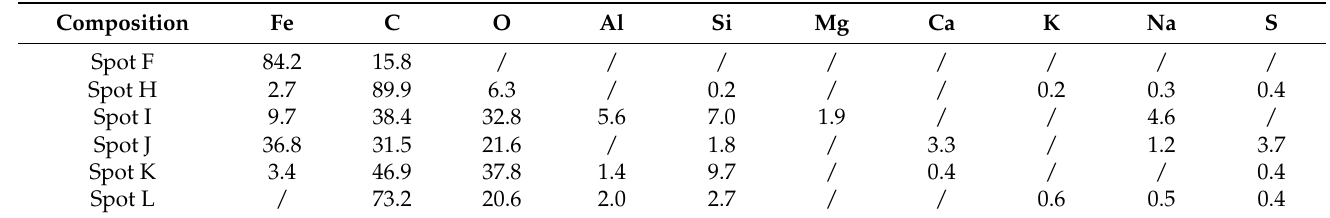
Figure 15. SEM images of the ( a ) magnetic concentrate and ( b ) acid leaching concentrate. Table 2. EDS results of the magnetic concentrate and acid leaching concentrate,